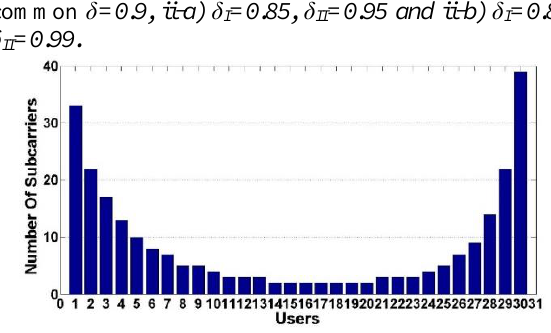
Fig. 3. Subcarriers allocation for increasing discount factor: δ i+1 = δ i +0.007 , δ 1 =0.777.